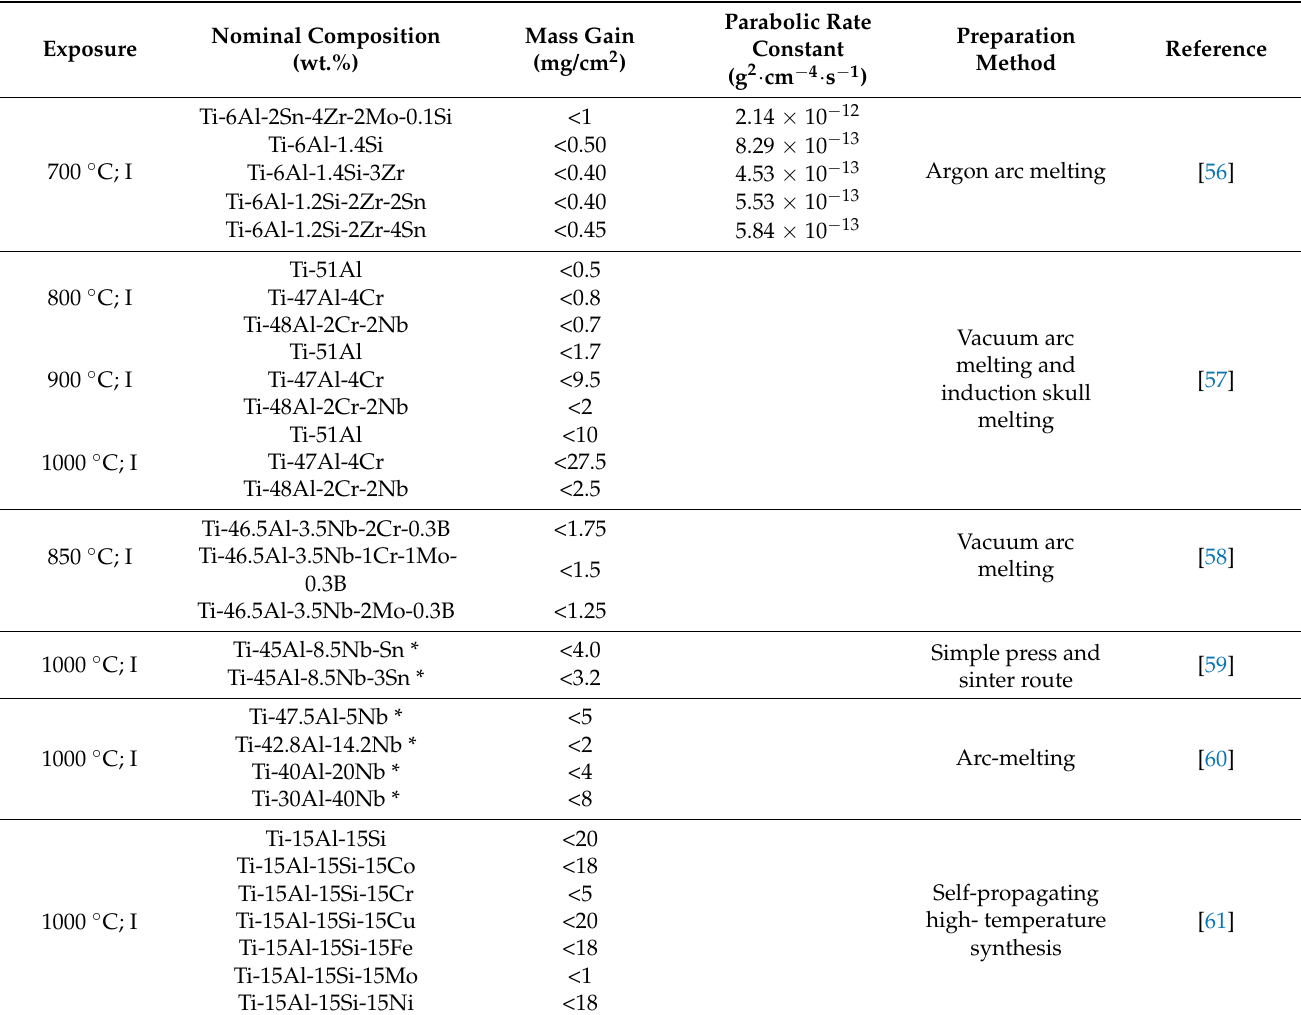
Table 3. Summary of the high-temperature exposure, nominal composition, mass gain, and parabolic rate constant for bulk Ti-Al alloy prepared by different